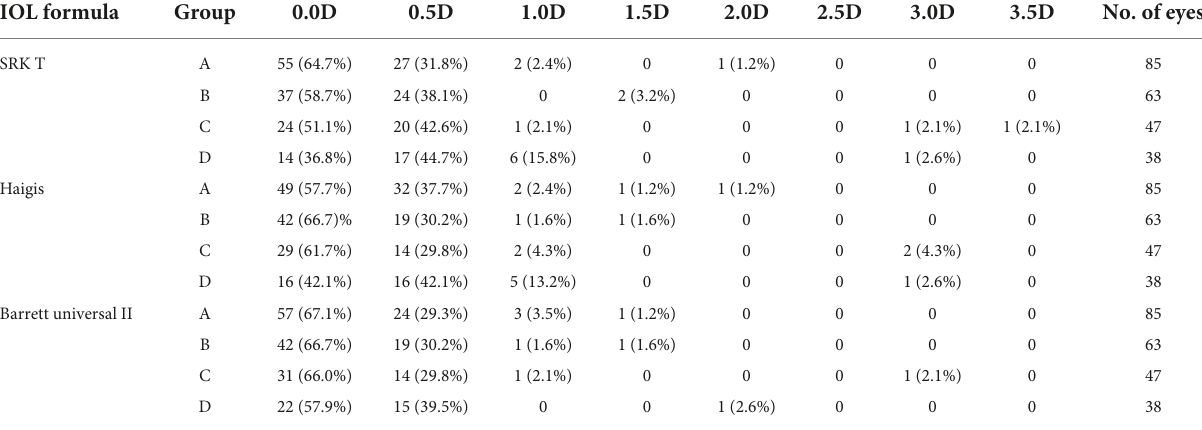
TABLE 3 The intraocular lens (IOL) power (D) difference before and after pupil dilation as discrete variable with changes in intervals of 0.5D. IOL formula